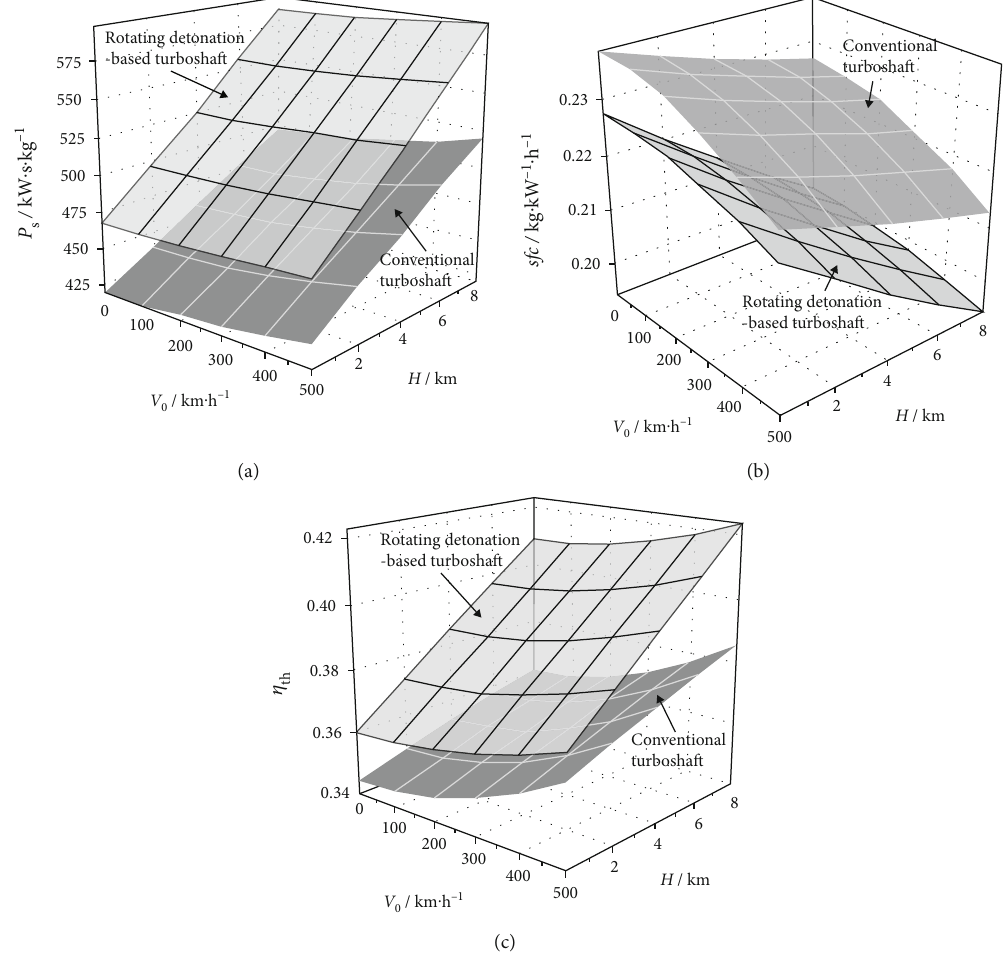
Figure 8: Performance comparison of turboshaft engine based on rotating detonation and the conventional one for di ff erent cycle parameters. (a) P s , (b) sfc , and (c) η th . Table 3: Variations in critical compressor pressure ratios π V π crit2 with 0 .